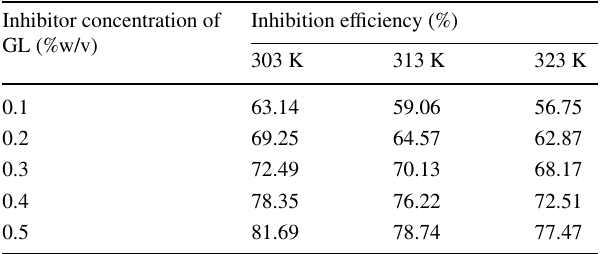
Inhibitor concentration of GL